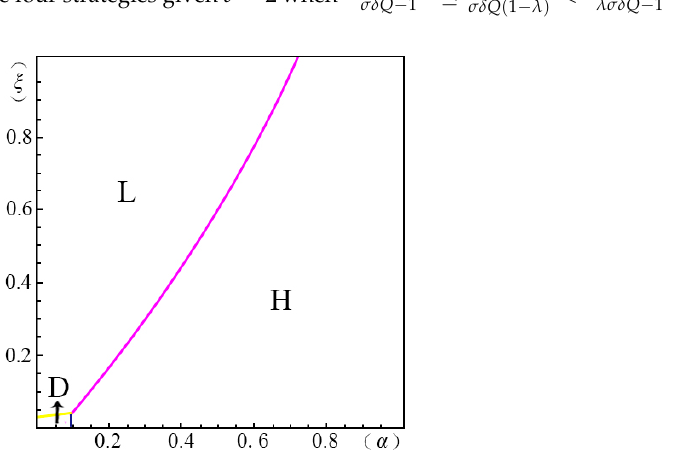
. Int. J. Environ. Res. Public 2017 , 14 , 1090 . Figure 4. Comparison of the four strategies given δ = 2 when p 2 A